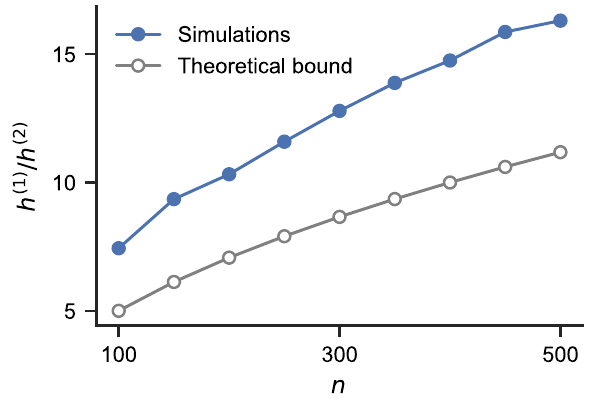
Fig. 4 | Higher-order interactions decrease degree heterogeneity in random hypergraphs. The degree heterogeneity (measured by h (1) and h (2) ) is stronger in the fi rst-order Laplacian L (1) than in the second-order Laplacian L (2) , and the dif- ferenceincreases withsystem size n . The theoreticallower bound of h ð 1 Þ n p and is independent of p . The simulation results are obtained from random 2 hypergraphs with different sizes n , using 500 samples for each n . The connection probabilities are set to p = p △